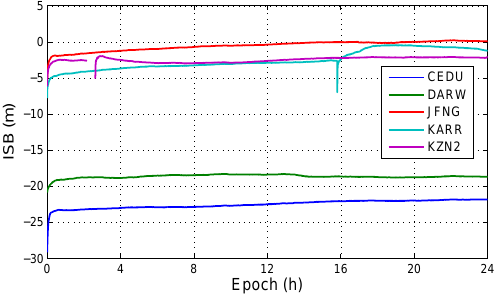
Figure 9. ISB at different stations in DOY 100,